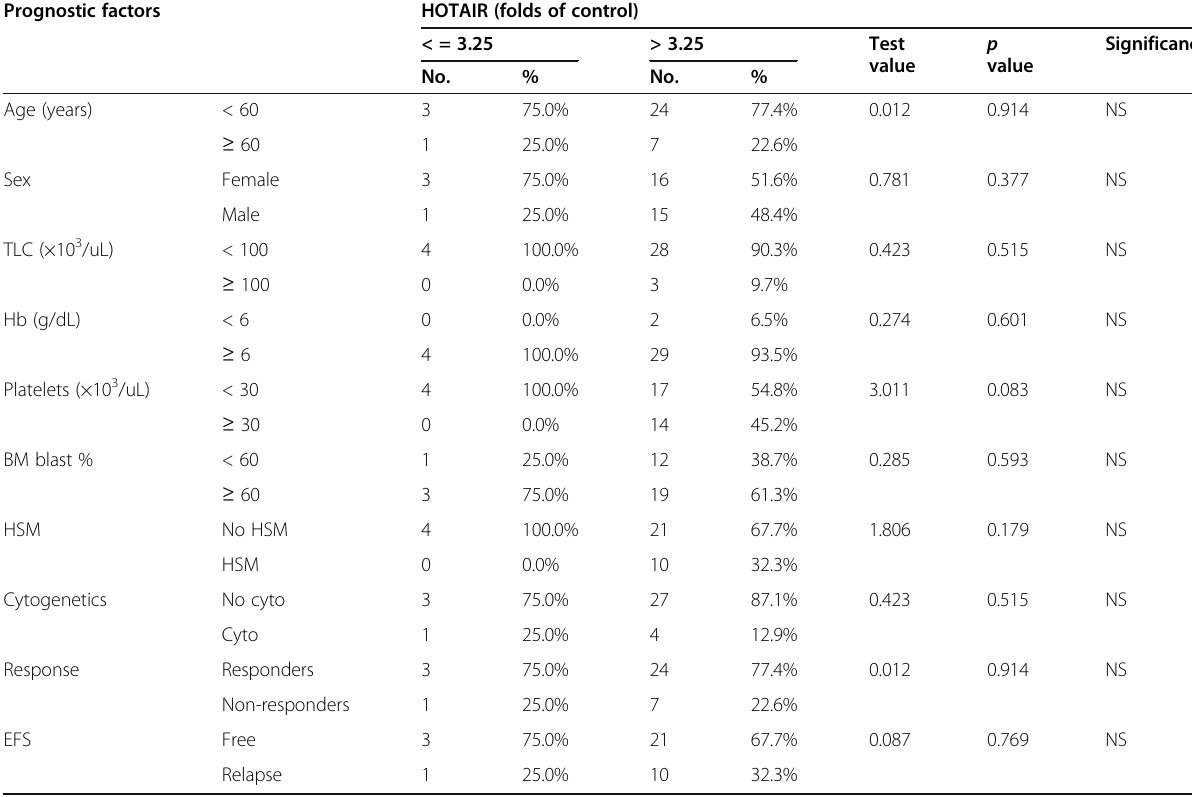
Table 9 Relation of HOTAIR expression to standard prognostic factors in AML Prognostic factors HOTAIR (folds of control)